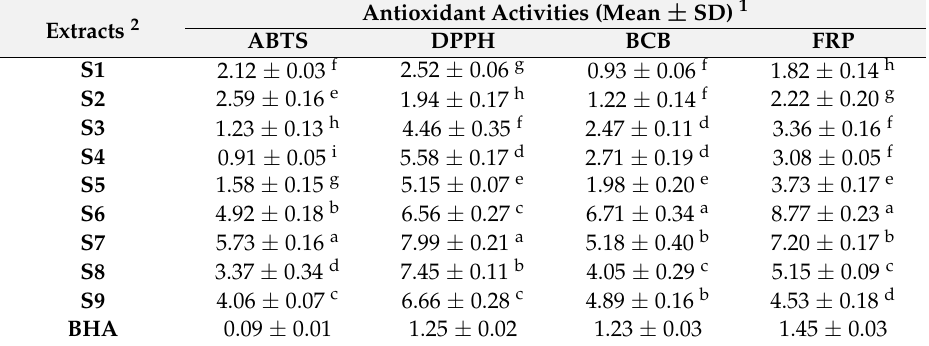
Table 2. Mean values and standard deviations for antioxidant activities of the pollen extracts under study.